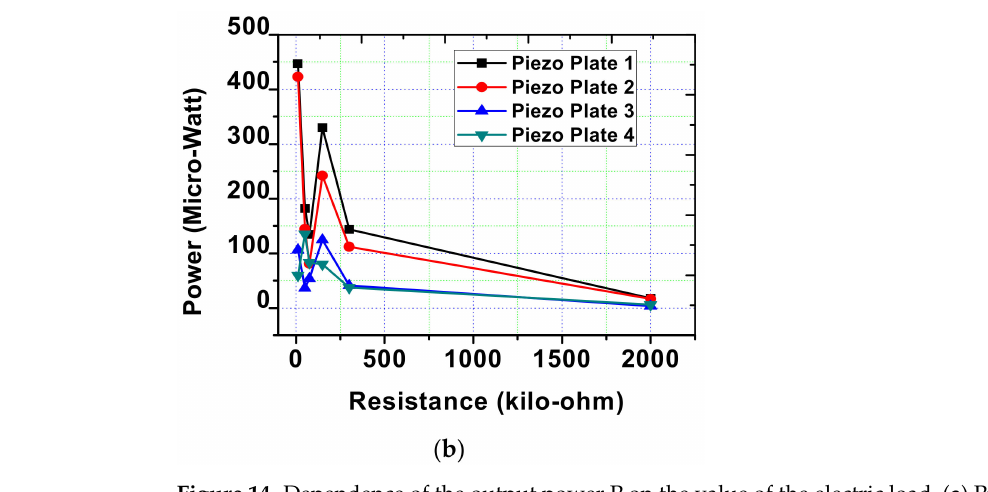
Figure 14. Dependence of the output power P on the value of the electric load, ( a ) Piezocylinders and ( b )